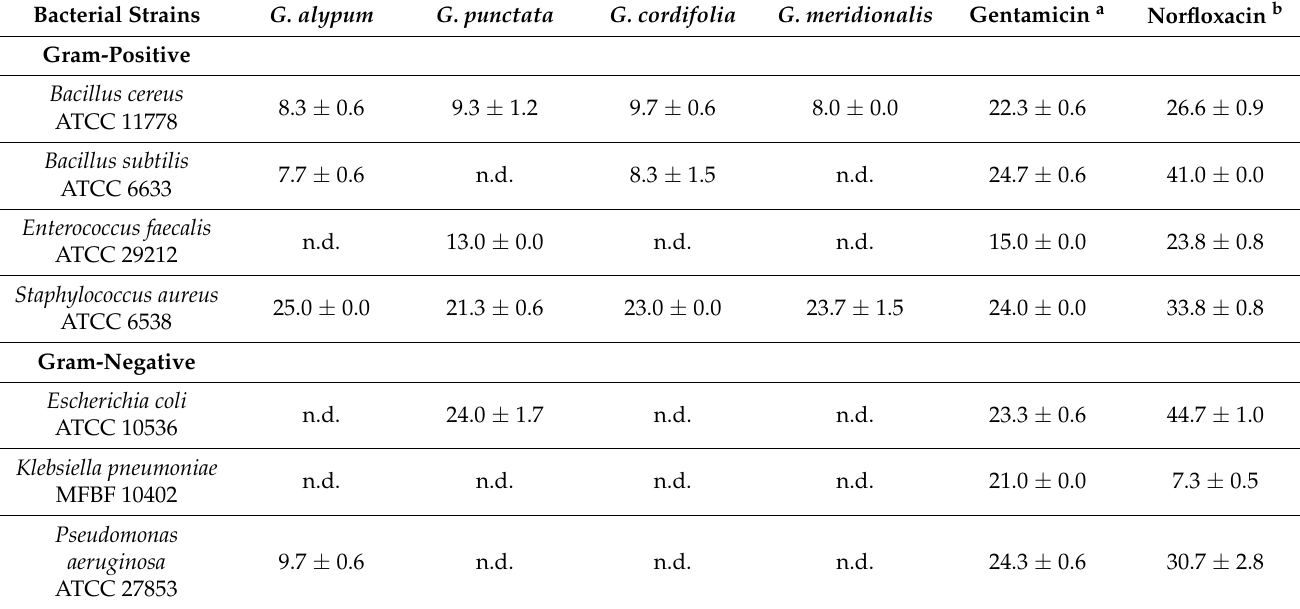
Table 7. Growth inhibition zones (mm) of G. alypum , G. punctata , G. cordifolia and G.